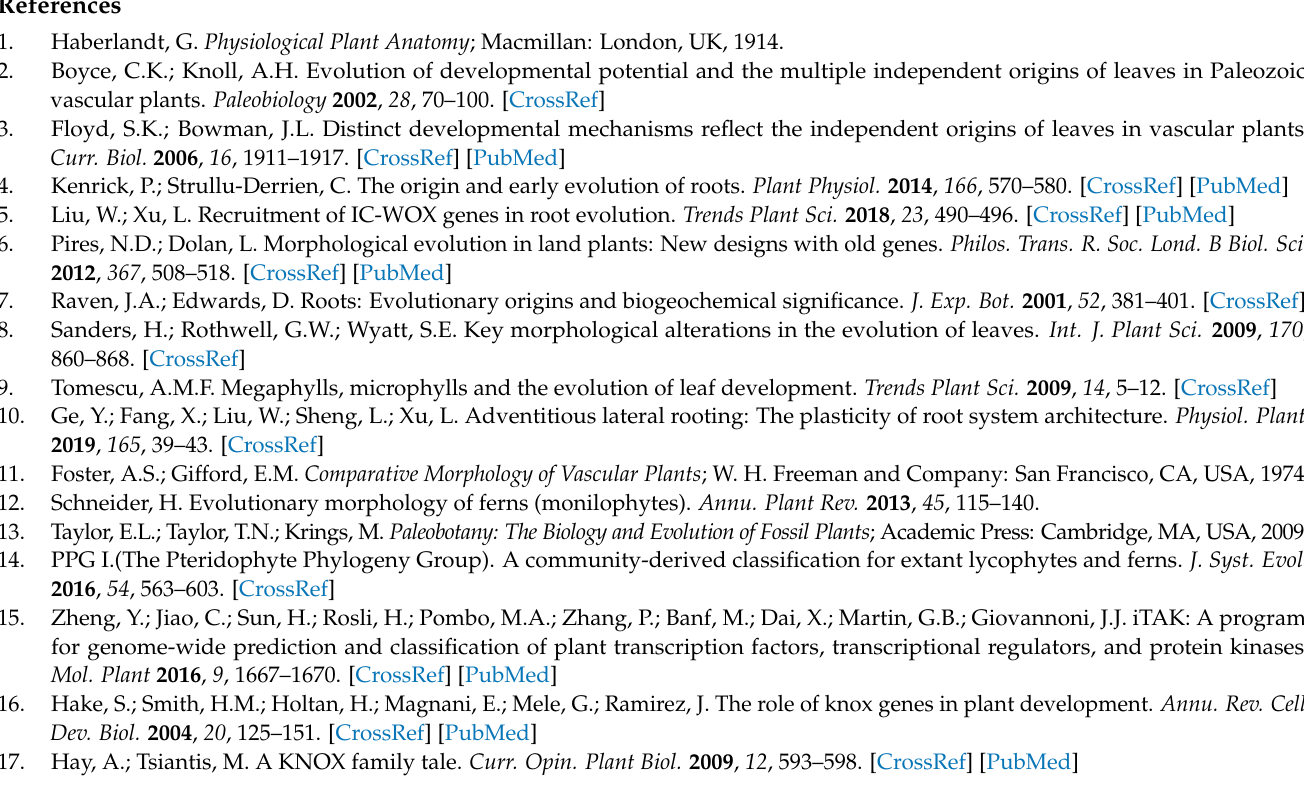
Table S4: The results of paml analyses for genes, where positive selection was detected in the branch of P. nudum ; Table S5: The results of paml analyses for genes, where positive selection was detected in the common ancestral branch of P. nudum and T. tannensis